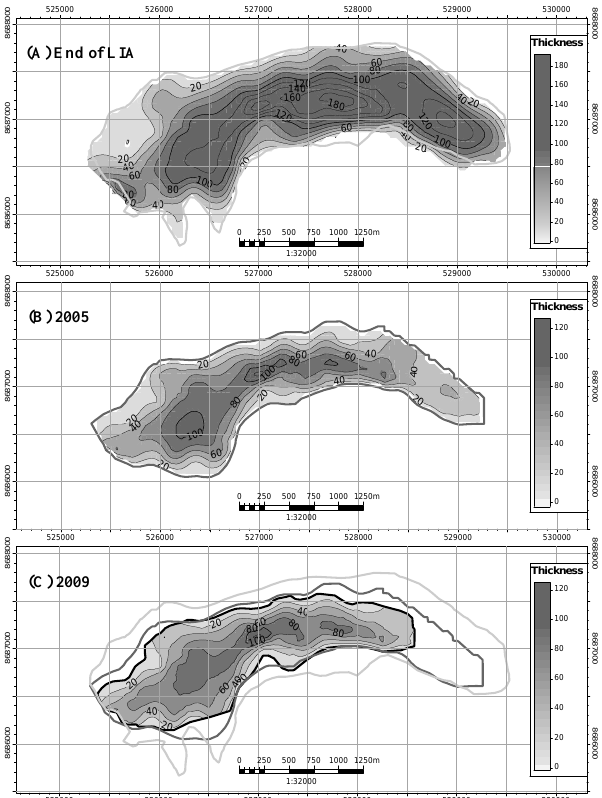
Fig. 5. Ice thickness maps and outlines of the glaciated area. NP 1:100.000 series map (light grey), 2005 measurements (dark grey) and 2009 measurements